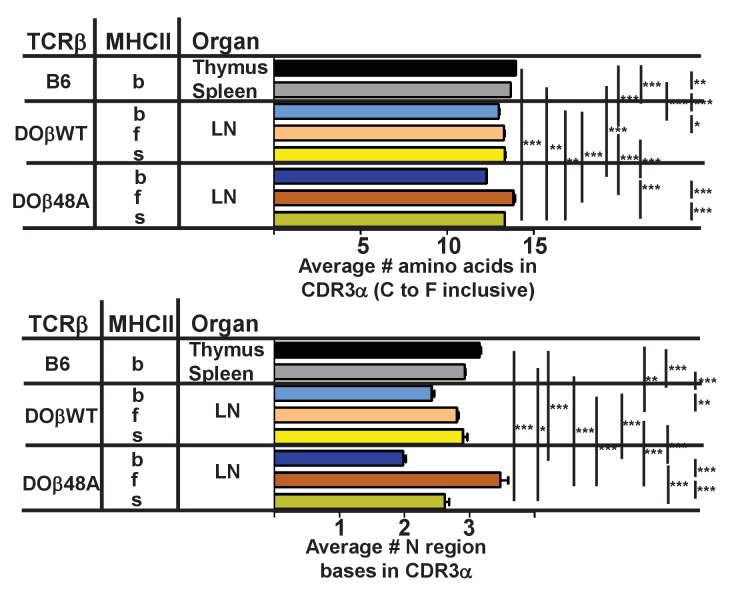
CDR3α length on naïve CD4 T cells depends upon the selecting MHC allele and the co-selected TCRβ.Data were obtained as described in Figures 3 and 4. Shown are the average lengths of CDR3α and N region bases on naïve CD4 T cells coexpressed with the indicated TCRβ. Results are the means and SEMs of 3 mice of the same haplotype except for s DOβWT mice, in which case the results from two mice were averaged. Errors are calculated with one way ANOVA with the Bonferroni post test comparing all pairs. *p<0.05, **p<0.01, ***p<0.001. Statistical results are omitted for pairs which were not significantly different from each other.